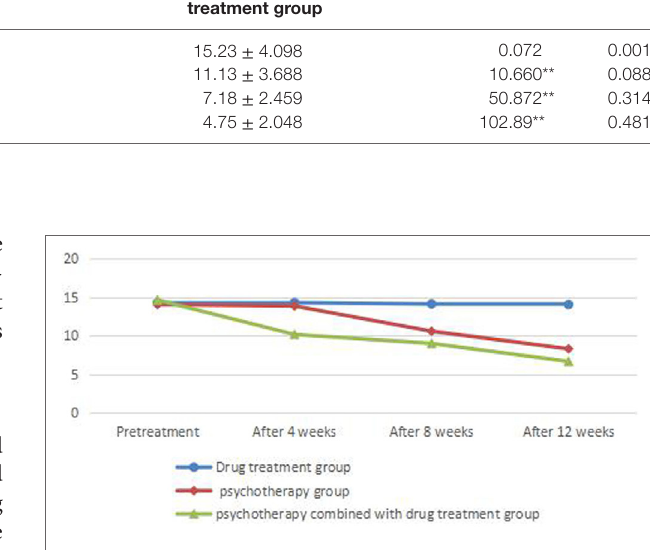
TaBle 2 | Comparison of HAMA scores before and after treatment in each group. Drug treatment group